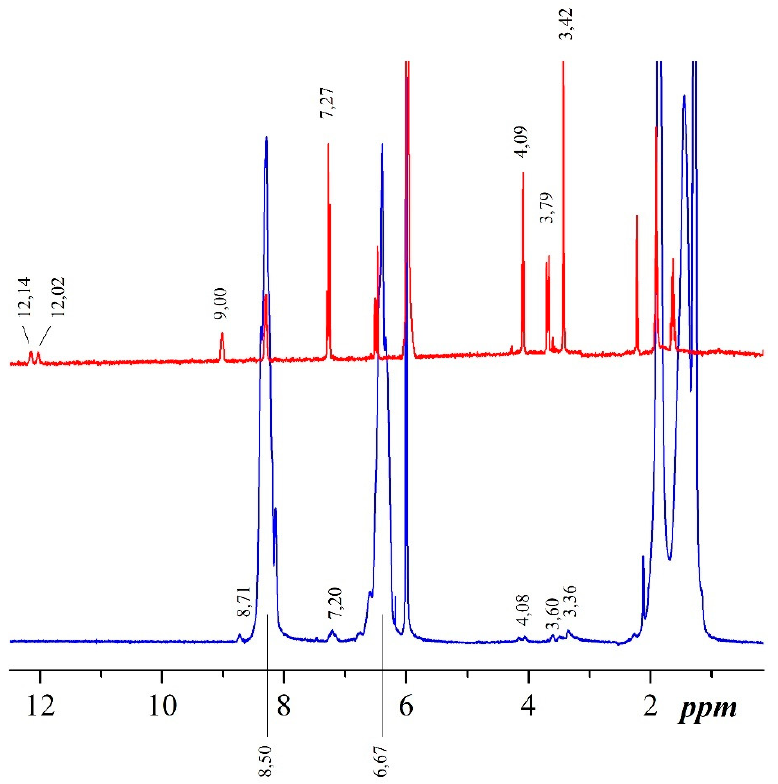
Figure 1. 1 H-NMR spectrum of L B (red curve) and the correspondent metallopolymer P B (blue curve). The diagnostic resonances are evidenced.